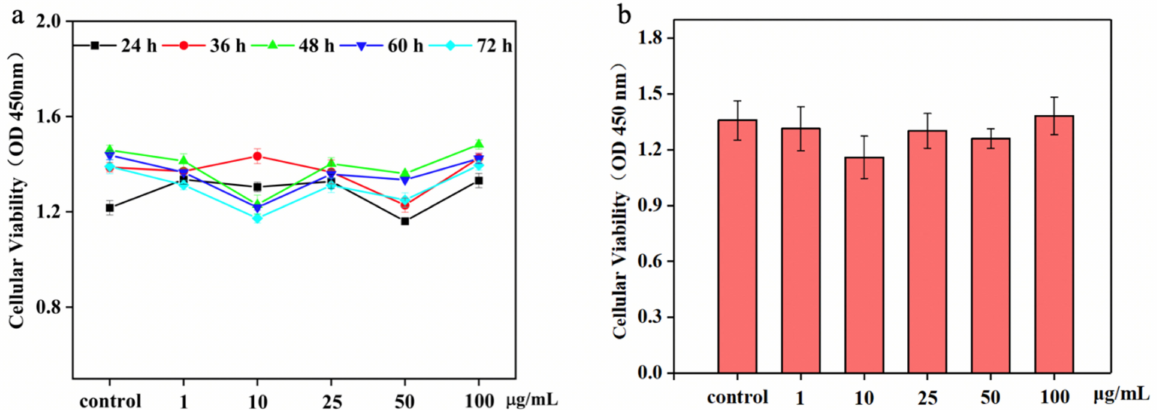
Figure 5. Effects of cell proliferation of varying concentrations of NTCII. ( a ) Cell survival at different time points. ( b ) Cell proliferation at 48